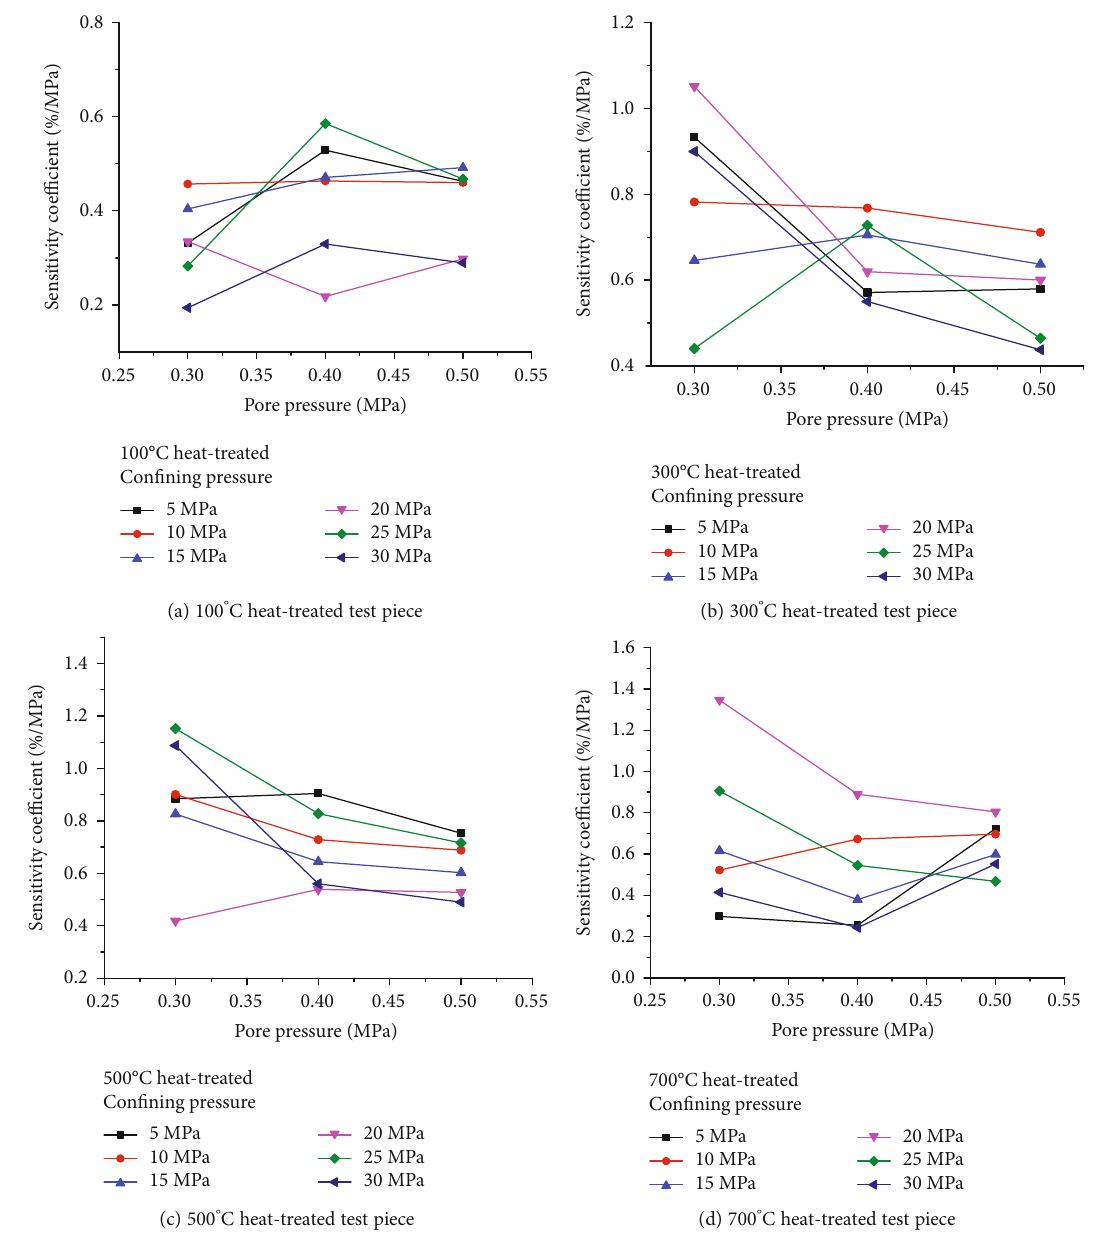
Figure 9: Pore pressure permeability sensitivity coe ffi cient